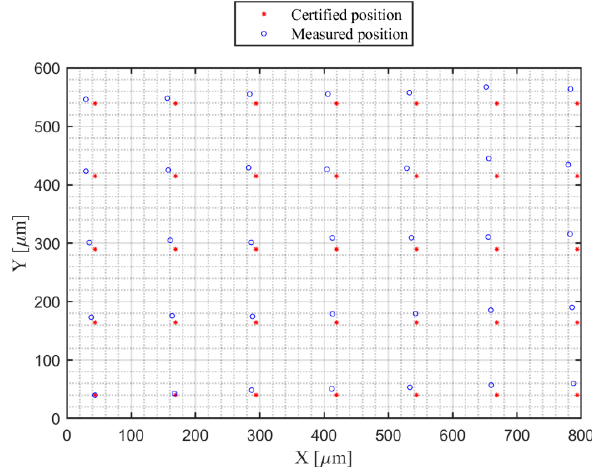
Figure 10. Plot of the cylinders’ centers and their corresponding certified positions.